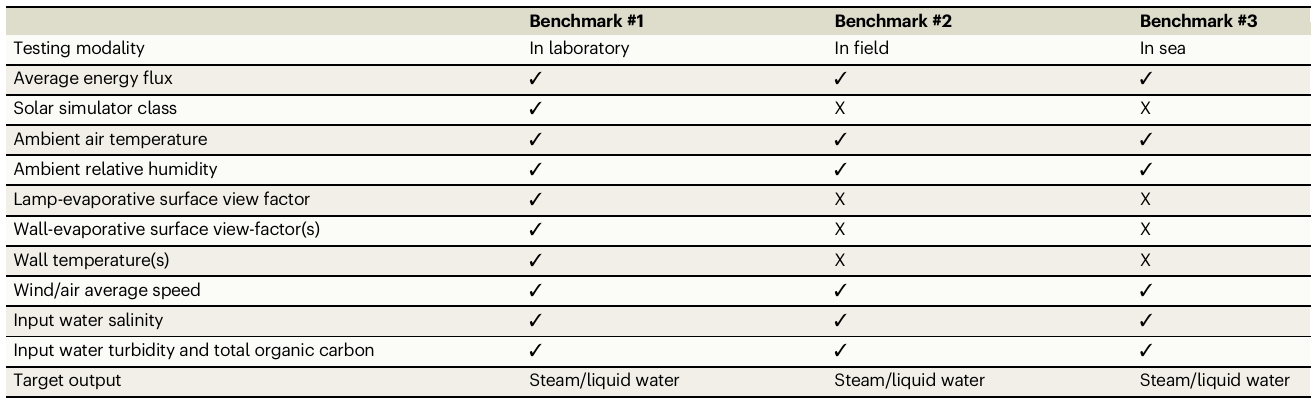
Table 1 | Checklist table of requested operating conditions for comparing different